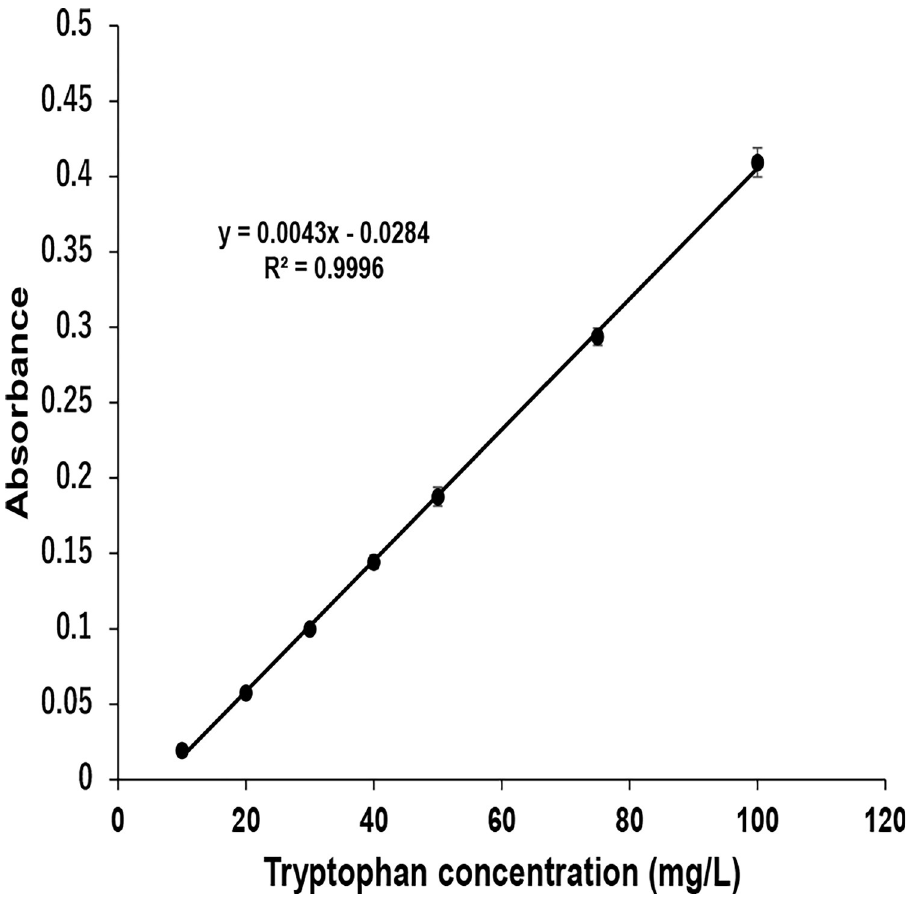
Fig 6. Calibration curve. Correlation between Trp concentration (10 to 100 mg/L) and absorbance (525 nm) under optimized conditions. Results are the mean ± S.D. of three experiments.